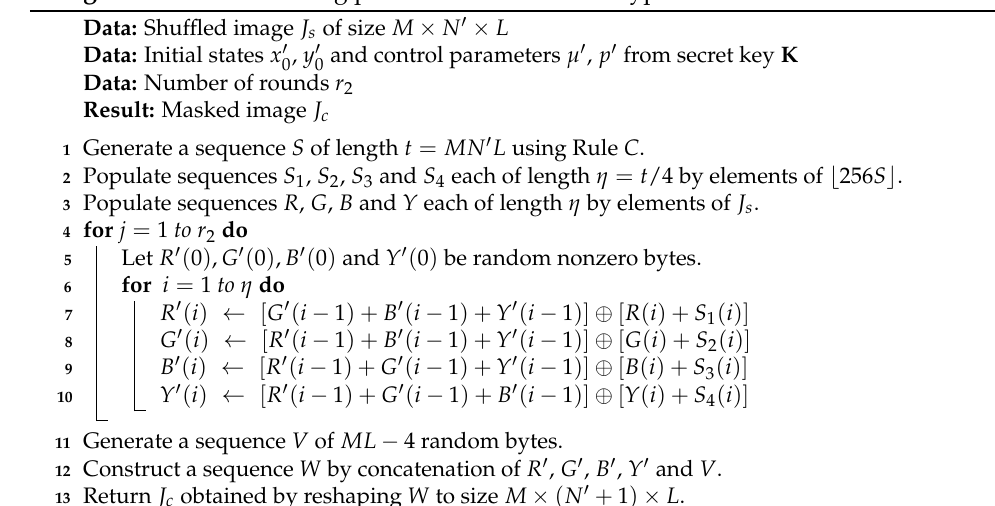
Algorithm 5: The masking phase of the lossless encryption scheme